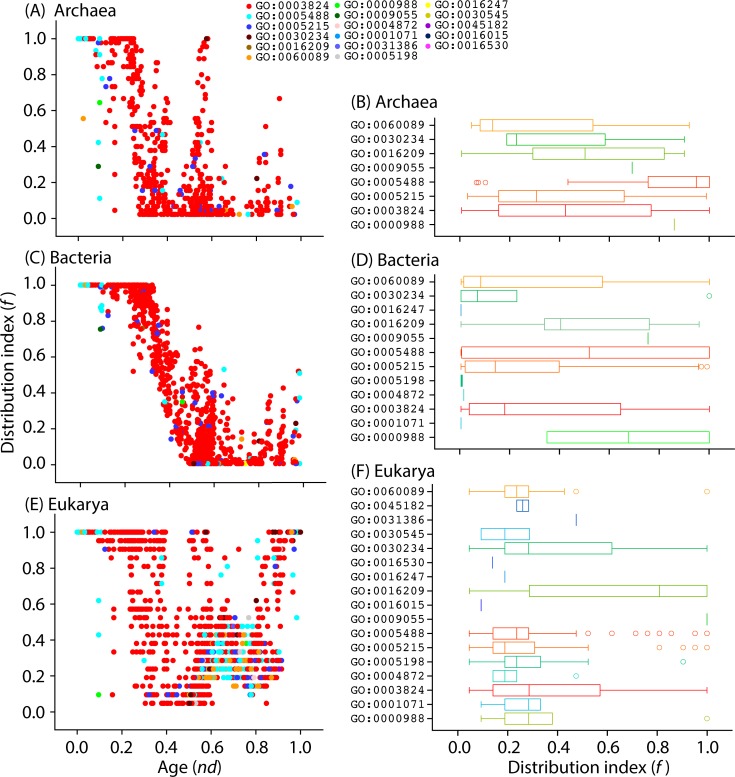
Order of the evolutionary appearance of level 1 GO terms in superkingdoms.(A) Scatter plot highlighting the distribution of level 1 GO terms in Archeae with respect to age (nd) and distribution in GOTMF terms. (B) Boxplots displaying distribution index of terminal terms in each level 1 category in Archaea. (C) Scatter plot highlighting the distribution of level 1 GO terms in Bacteria with respect to nd and distribution in GOTMF terms. (D) Boxplots displaying distribution index of terminal terms in each level 1 category in Bacteria. (E) Scatter plot highlighting the distribution of level 1 GO terms in Eukarya with respect to nd and distribution in GOTMF terms. (F) Boxplots displaying distribution index of terminal terms in each level 1 category in Eukarya.